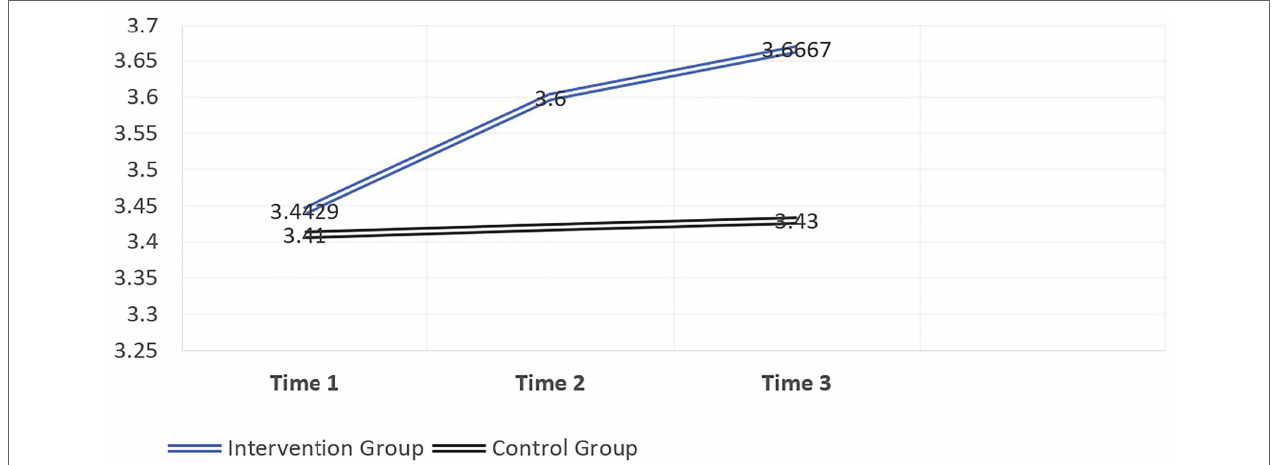
FIGURE 2 | Intervention and Control Mean over Time 1, 2, and